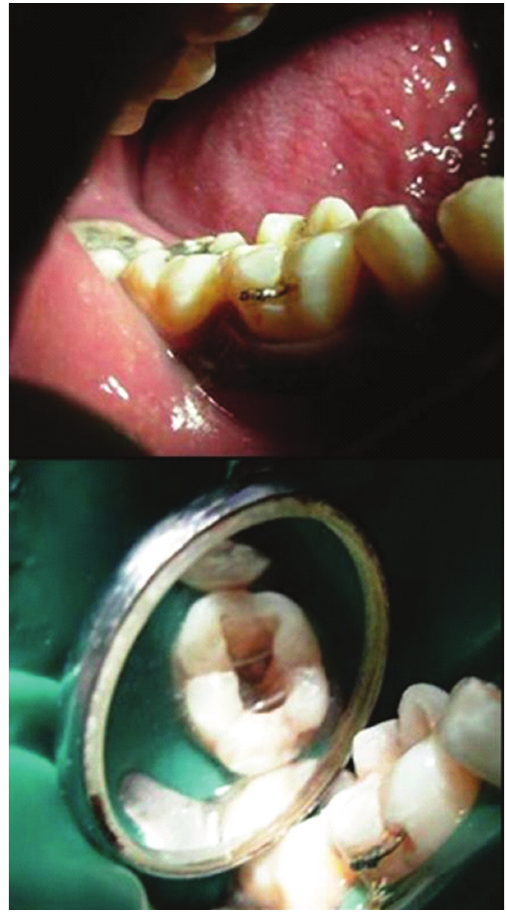
Figure 4: Wire reinforcement (buccal view), wire reinforcement (occlusal view).